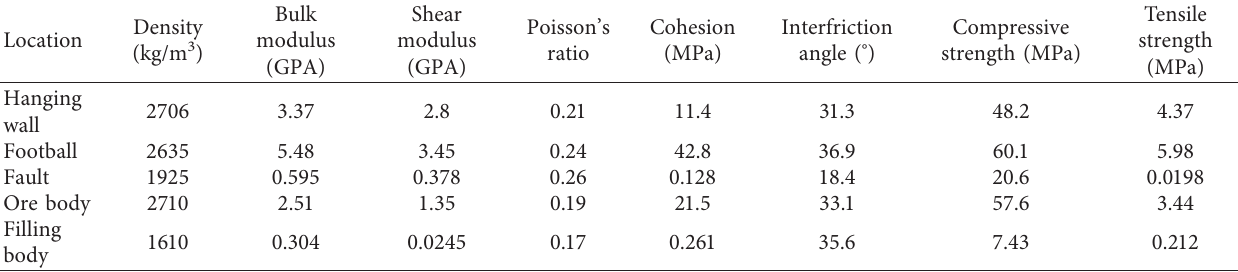
Table 1: Physical and mechanical parameters for a numerical simulation model.